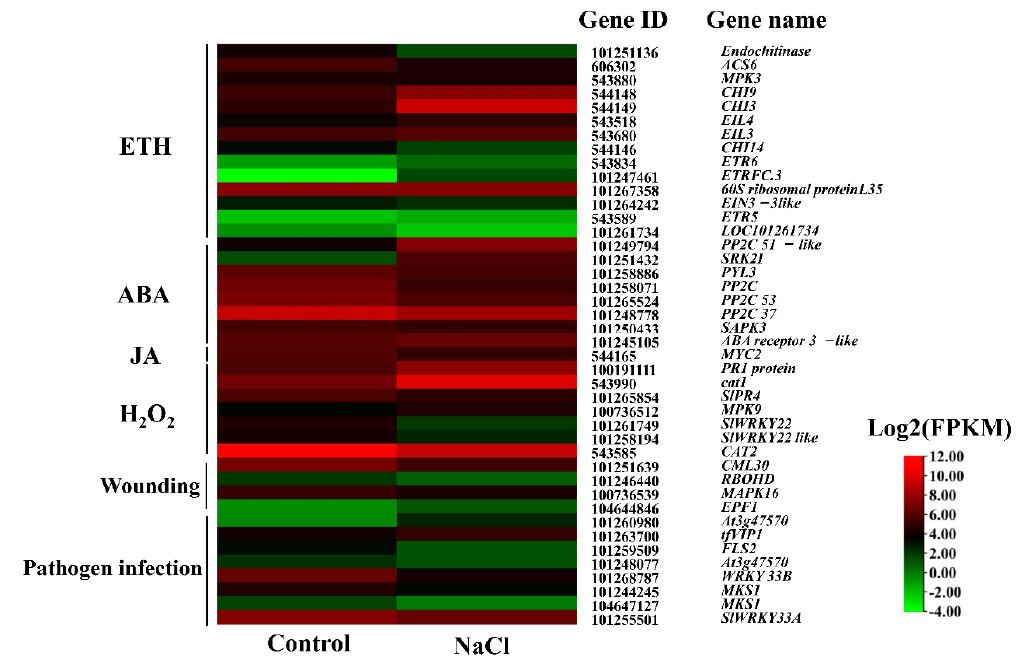
Figure 3. Expression patterns of differentially expressed genes related to MAPK signaling pathway during salt stress. The color scale corresponds to log 2 − transformed (fragments per kilobyte per million reads) FPKM values with red indicating upregulation and green indicating downregulation. Each row represents a unigene. Control and NaCl represented different treatments.